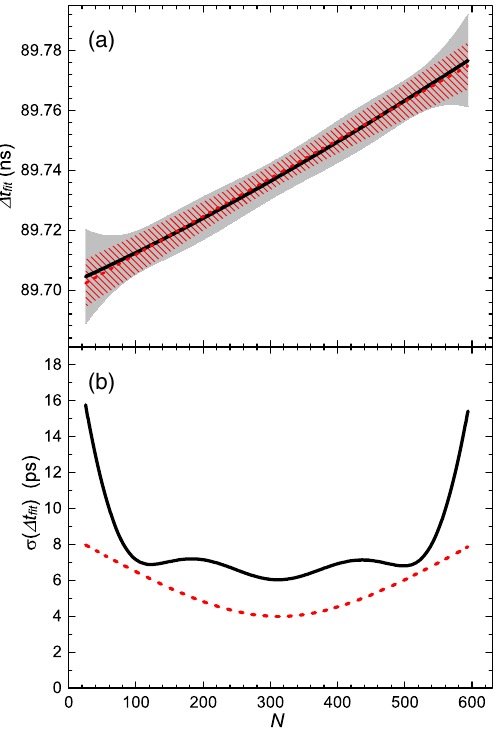
FIG. 5. (a) Δ t values obtained by using Eq. (5) as a function of fit the revolution number N . The data are for the single 45 V 23 þ ion presented in Fig. 2. (b) The 1 σ uncertainty of the Δ t σ ð Δ t Þ . The black solid line and gray solid shadow correspond to fit the fitting with all parameters set free. The red dashed line and red hatched area correspond to the fitting process with Δ a 2 ¼ Δ a 3 ¼ 0 (see